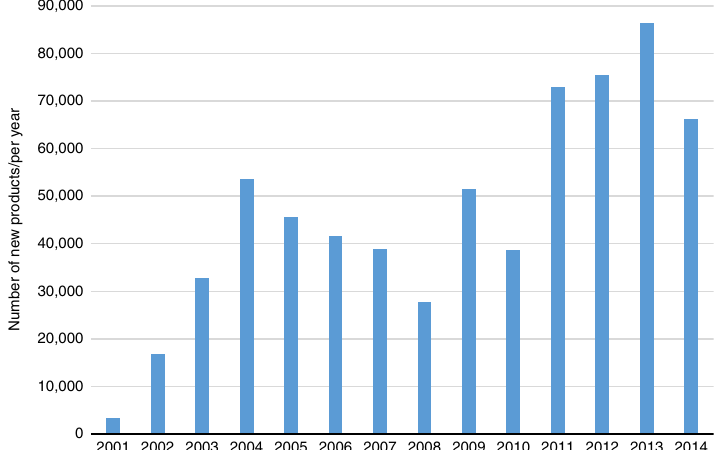
Figure 1. The number of automakers ’ new products approved